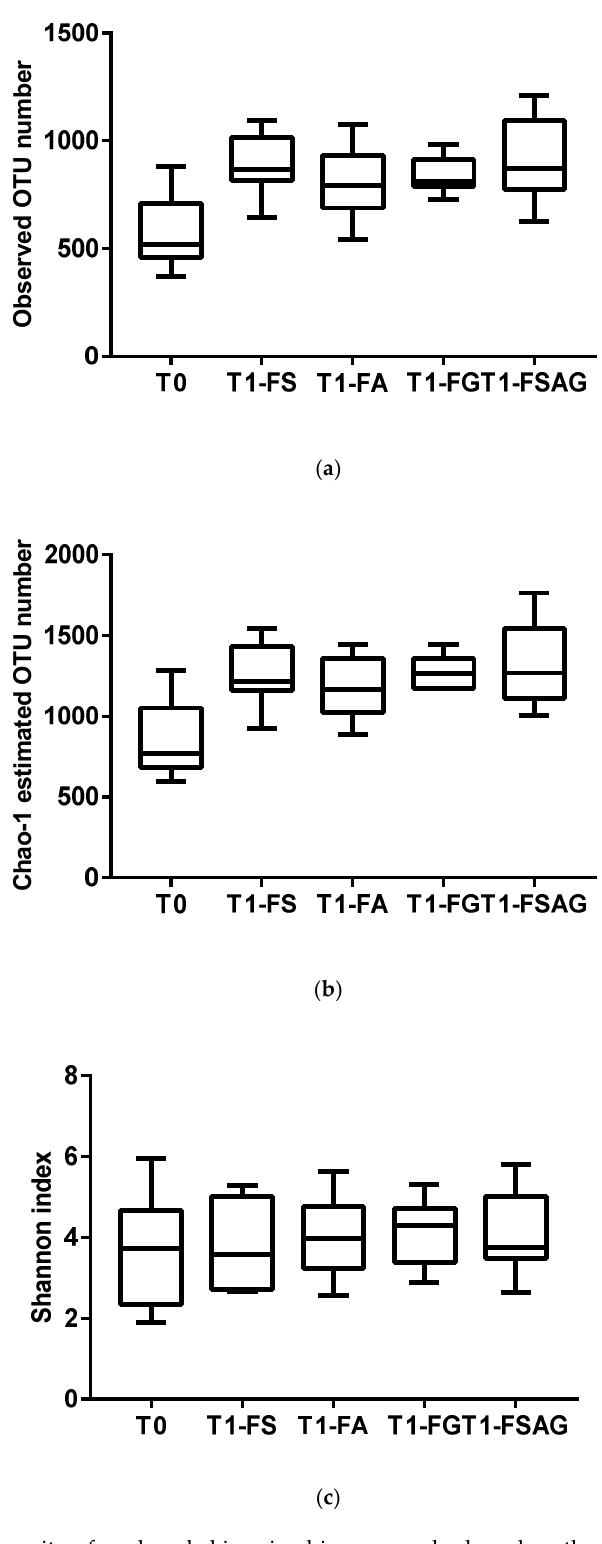
Figure 1. Alpha diversity of analyzed skin microbiome samples based on the ( a ) observed and ( b ) Chao1-estimated Observed Taxonomic Unit (OTU) numbers and the ( c ) Shannon index. T0: baseline; F-Shiunko (T1-FS); F-Artemisia (T1-FA); F-Glycyrrhiza (T1-FG); combination